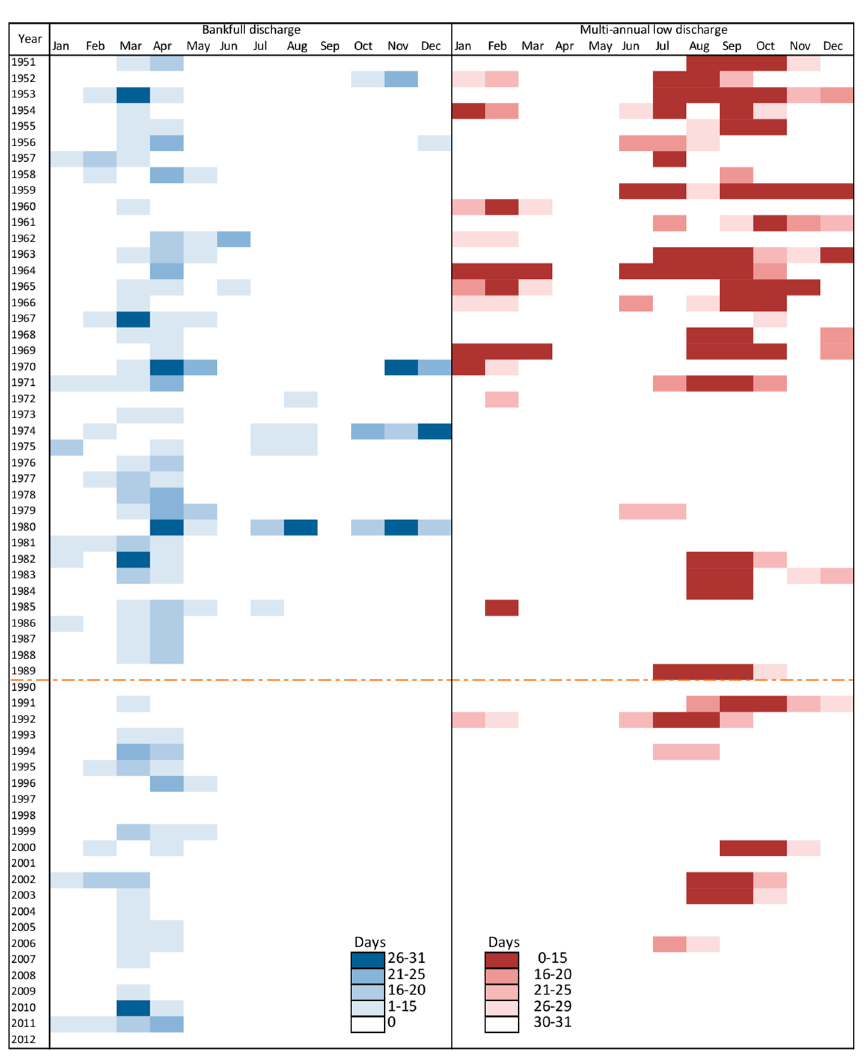
Figure 9. Matrix presenting the occurrence and duration of floods (blue) and droughts (red) of the Narew River at the Sura ż gauge station.